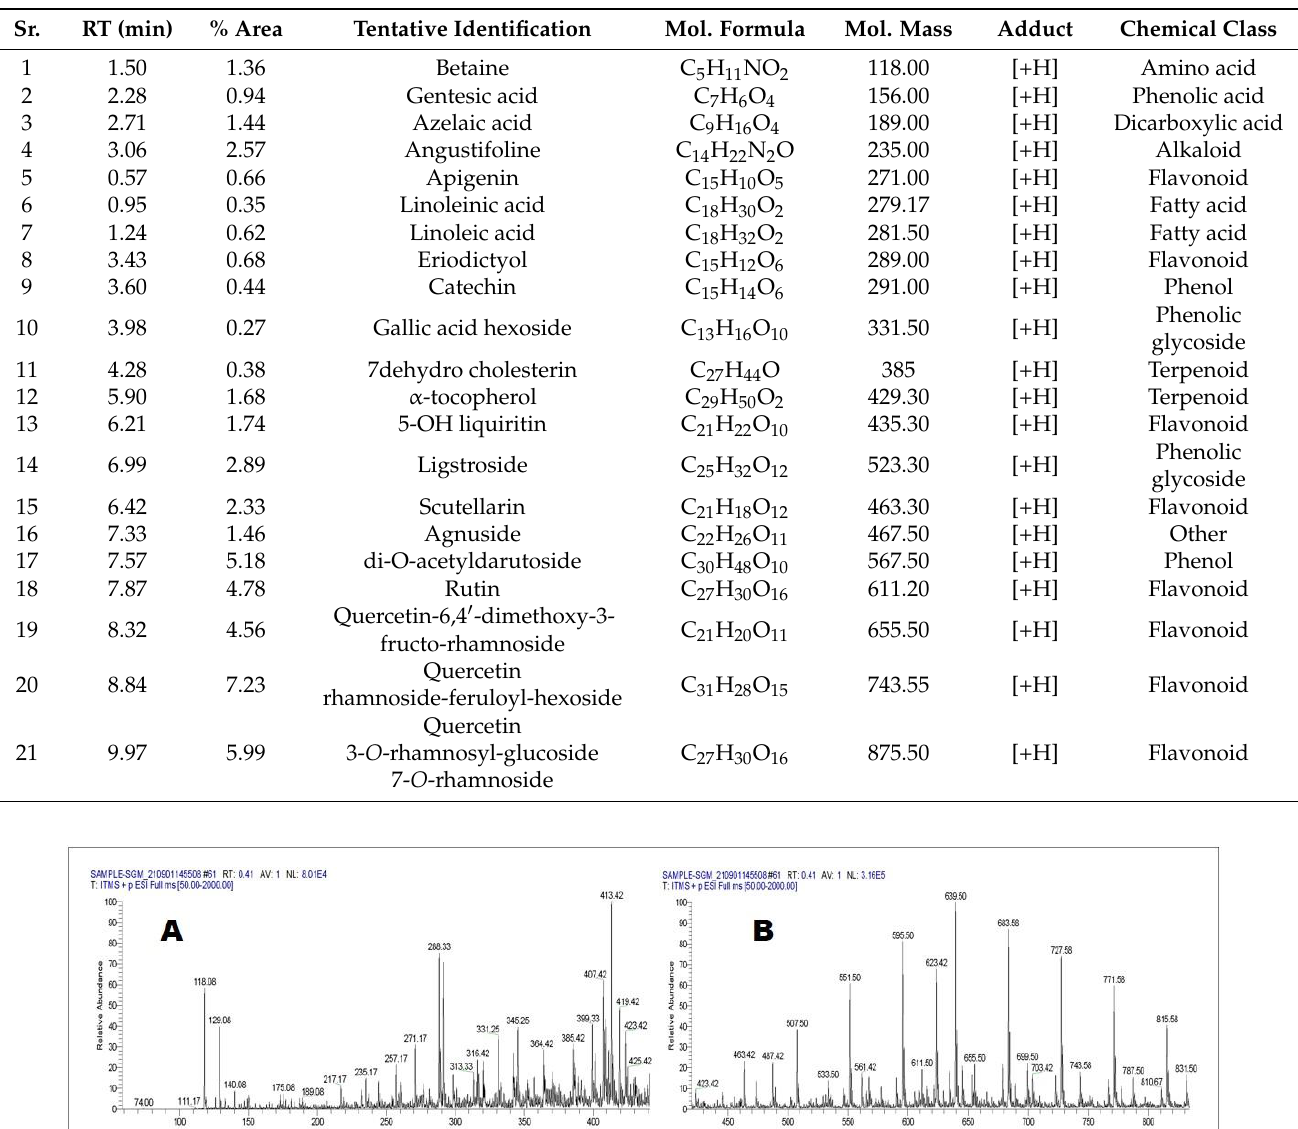
Table 4. LC-ESI-MS-MS screening of Strobilanthes glutinosus in positive mode.